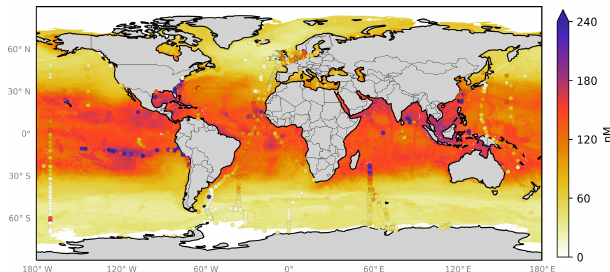
Figure 6. Annual average predicted sea-surface iodide by the 10- member ensemble of models (RFR(Ensemble)), overlaid with io- dide observations from Chance et al. (2019a) without outliers. Out- liers are defined here as values greater than the third quartile plus 1.5 times the interquartile range (Frigge et al., 1989). Only locations that are entirely water are included in the spatial average. Earth raster and vector map data used are freely available from Natural Earth (http://www.naturalearthdata.com/, last access: 23 July 2019).